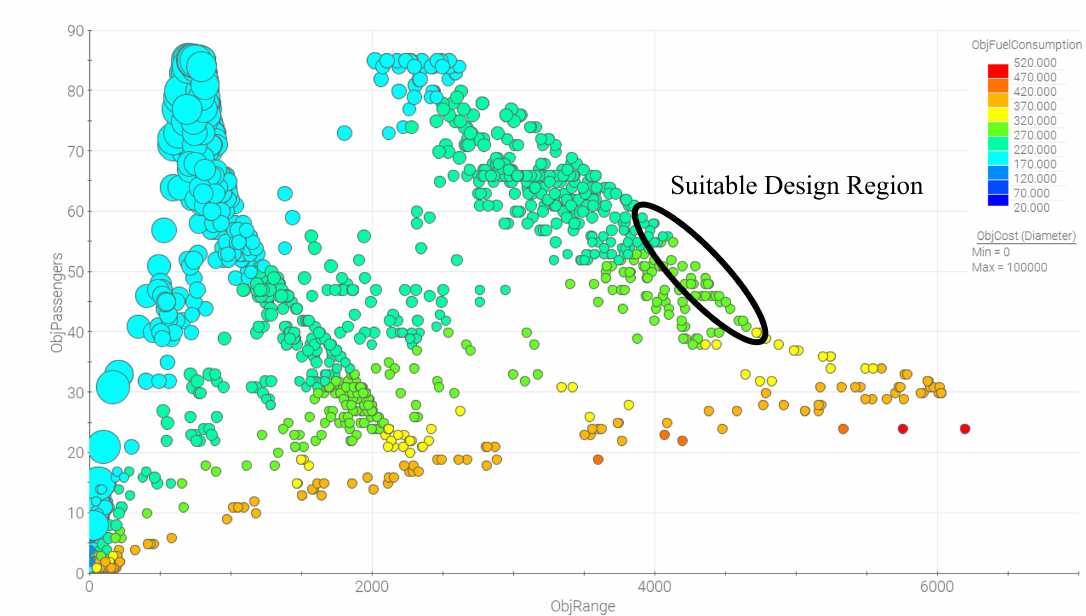
Figure 10. A four-dimensional bubble chart, where the range objective is represented on the x-axis, the passenger capacity on the y-axis, the fuel consumption as the color gradient, and the overall cost objective as the size of the individual